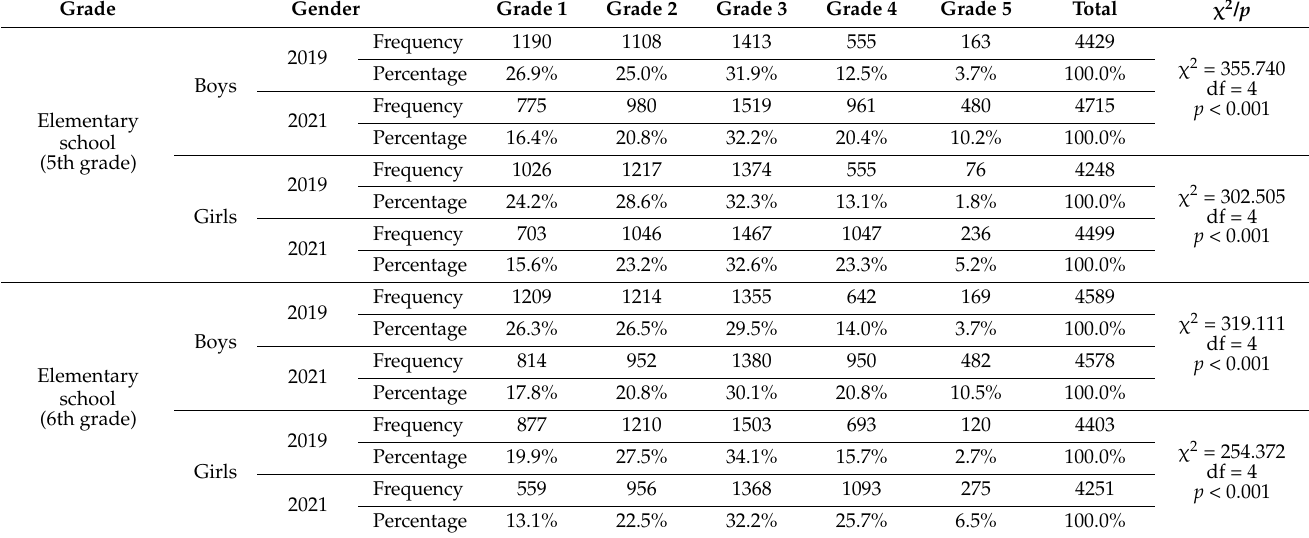
Table 3. Comparison of cardiorespiratory endurance in 2019 and